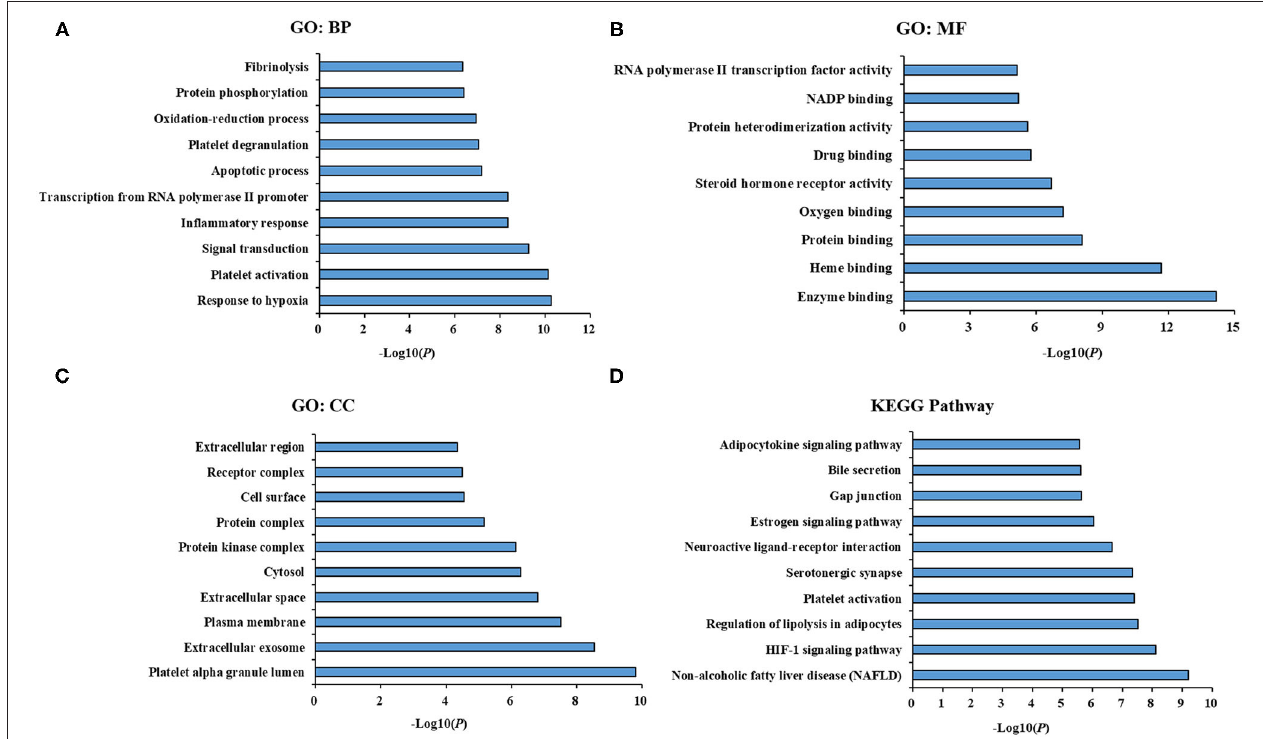
FIGURE 3 | GO term performance and pathway enrichment analysis of major hubs. (A) GO term performance by a biological process (BP); (B) GO term performance by a molecular function (MF); (C) GO term performance by a cellular component (CC); (D) pathway enrichment analysis by KEGG. The ordinate stands for GO terms or main pathways, the primary abscissa stands for minus log10( P